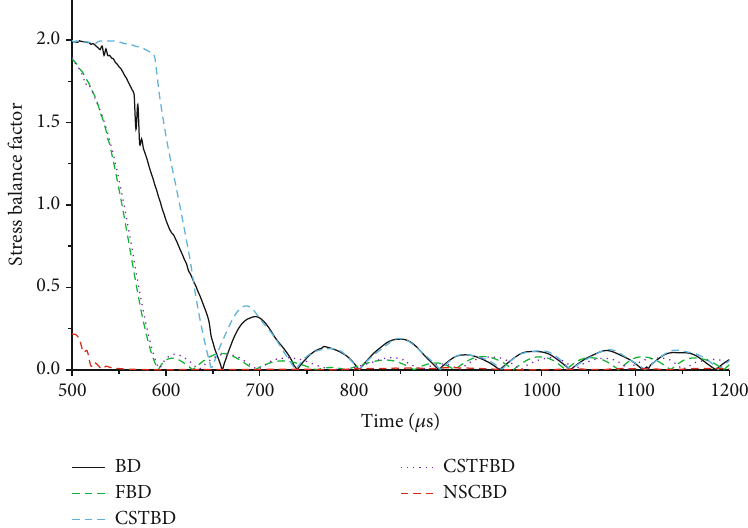
Figure 15: Stress balance factor time history curve of fi ve con fi guration